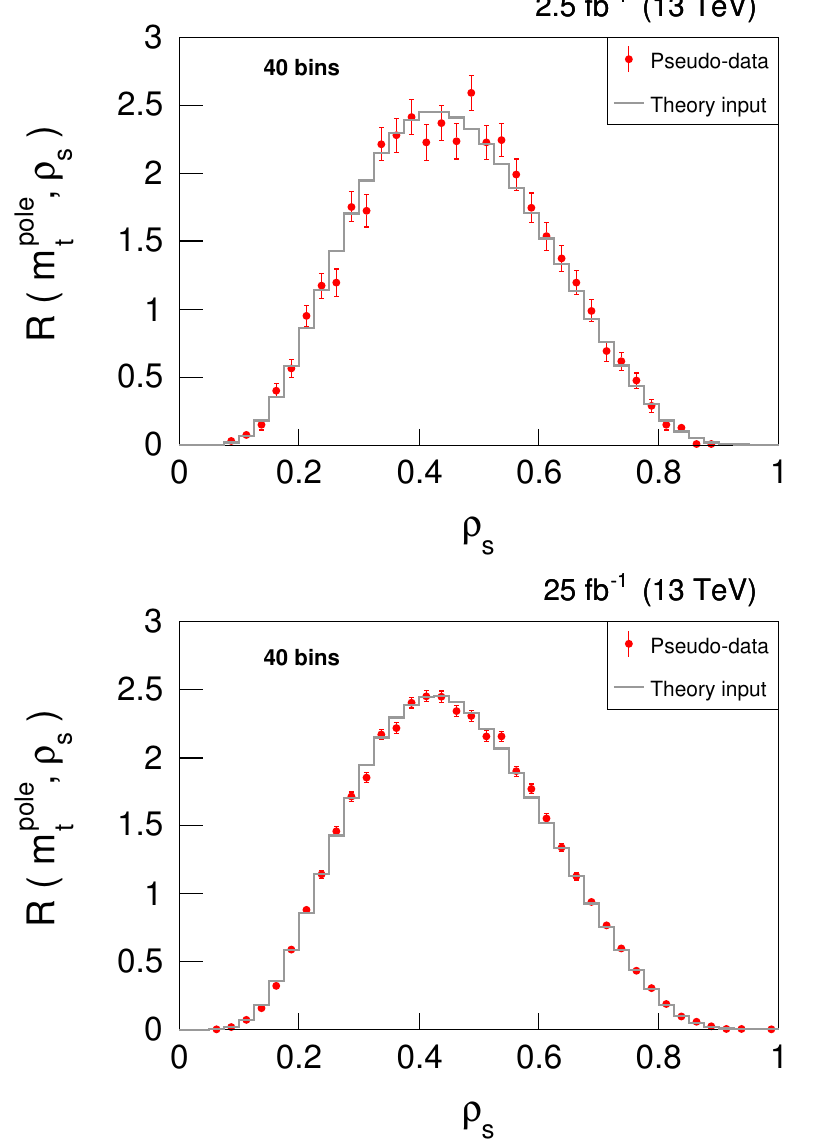
Figure 4 . One pseudo-data set (red points) as generated from the NLO QCD calculations for the pp e + (cid:23) e (cid:22) (cid:0) (cid:22) (cid:23) (cid:22) b (cid:22) bj + X production process at the LHC with p s = 13 TeV. The Full approach with ! m t = 173.2 GeV is used. The underlying NLO template (grey histogram) is also shown. Two cases of the integrated luminosity are presented, namely 2.5 fb (cid:0) 1 and 25 fb (cid:0) 1